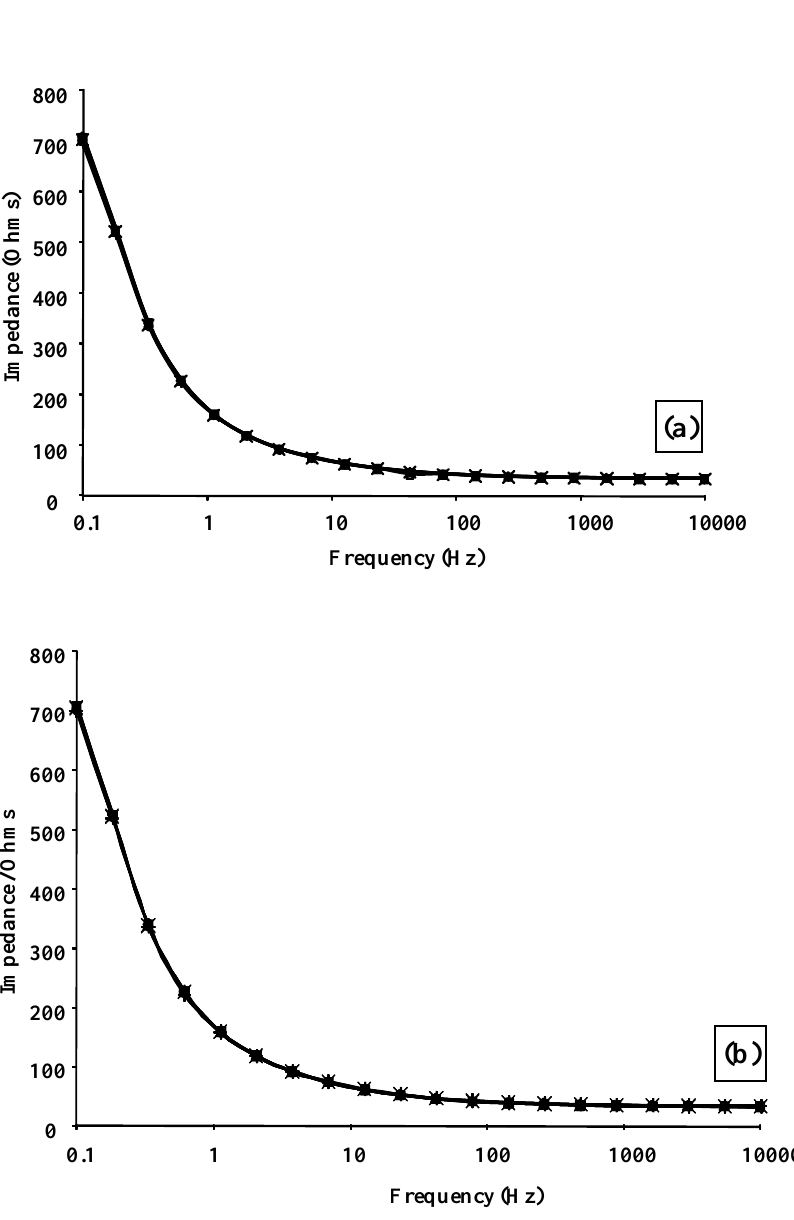
Figure 12. Plot of total impedance versus frequency for a poly(aniline)/alcohol oxidase microelectrode array exposed to a range of ethanol concentrations under (a) aerobic and (b) anaerobic conditions: ( ) 0 mM; ( ) 1 mM; ( ) 5 mM; (×) 10 mM; (*) 20 mM; ( ) 30 mM; (+) 40 mM―N.B. Plots are seen to converge due to scale utilised. Plots of percentage change (relative to 0 mM ethanol) impedance versus frequency for a poly(aniline)/alcohol oxidase microelectrode array exposed to a range of ethanol concentrations under (c) aerobic and (d) anaerobic conditions: ( ) 1 mM; ( ) 5 mM; ( ) 10 mM; (×) 20 mM; (*) 30 mM; ( ) 40